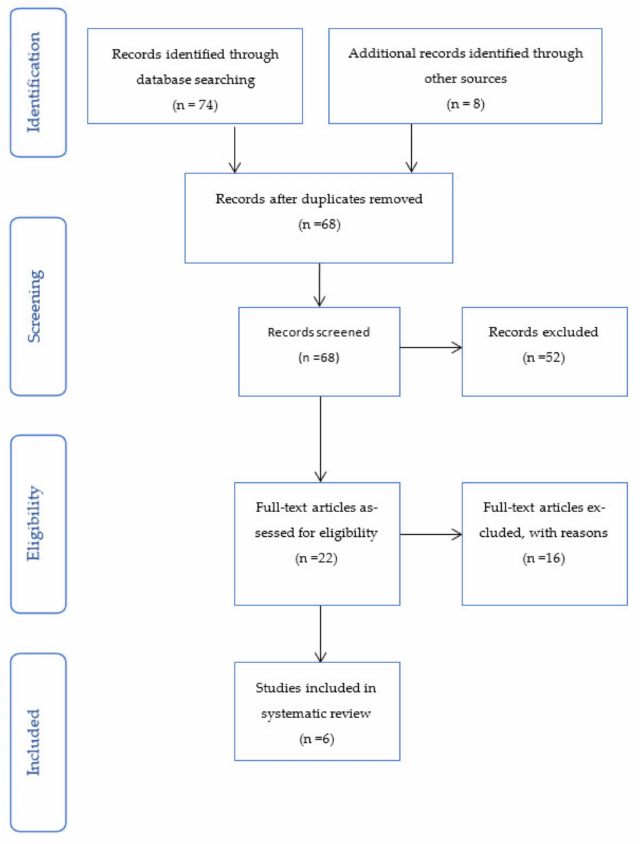
Figure 4. A PRISMA diagram demonstrating the study selection process for study question 2—Does sperm selection by HAB improve the rate of pregnancy loss in IVF or ICSI